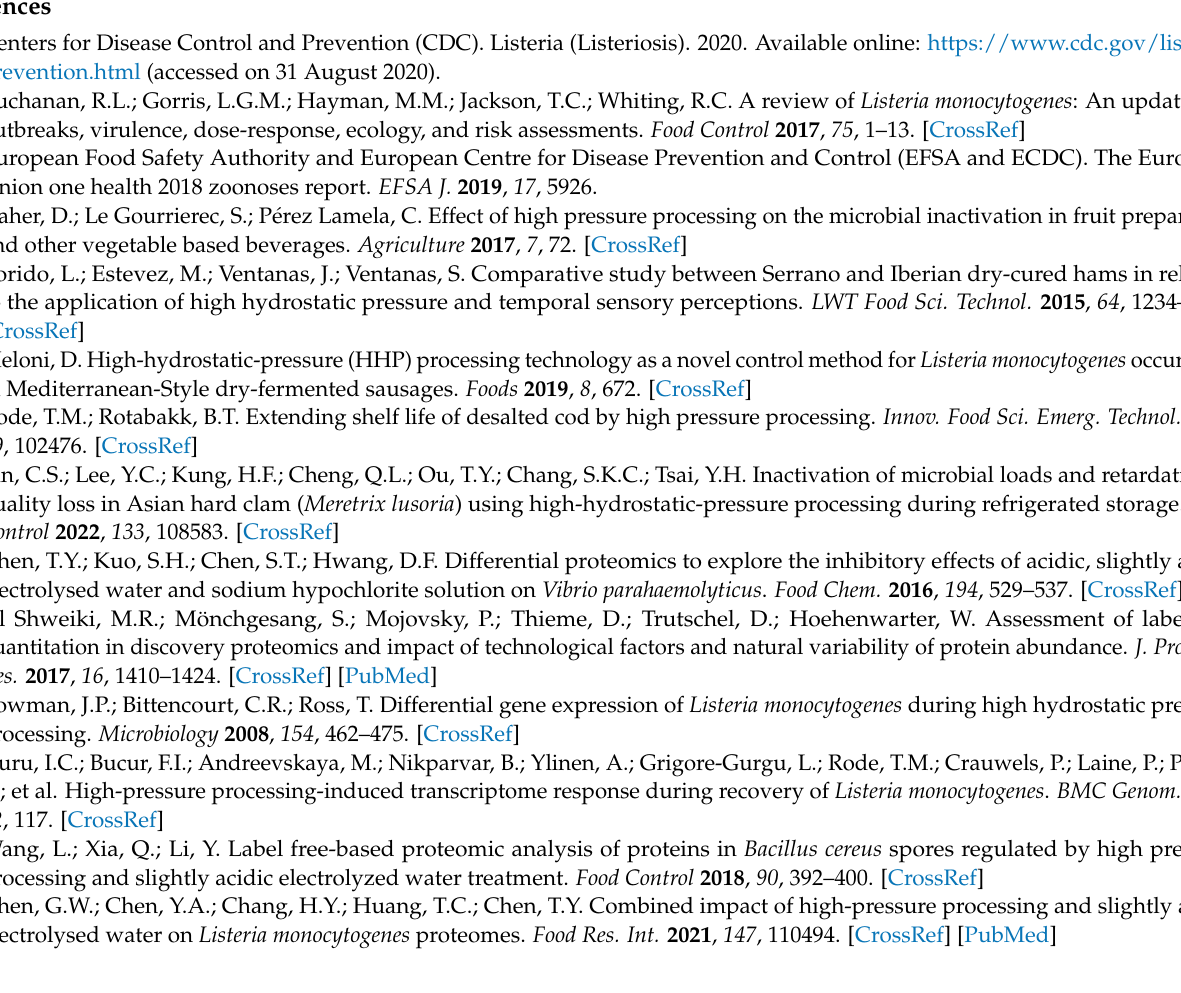
Figure S2: The numbers of differential expressed proteins (DEPs) of L. monocytogenes exposed to HPP. Figure S3: The optimal number of clusters under k-means clustering algorithm. Table S1: Bactericidal efficacy of L. monocytogenes exposed to HPP. Table S2: The number of proteins in each cluster by k -means. Table S3: Characteristics of DEPs grouping under k -means clustering algorithm. Table S4: Identification of DEPs of L. monocytogenes after H2 and H4 treatments by